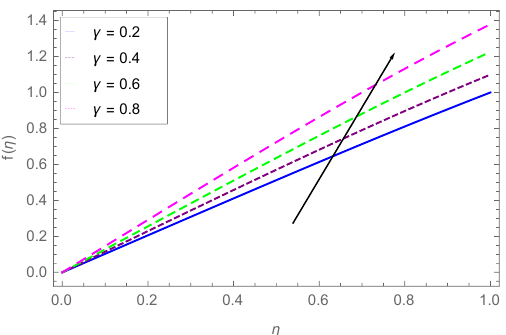
Figure 3. Plot showing f ( η ) dependence on γ